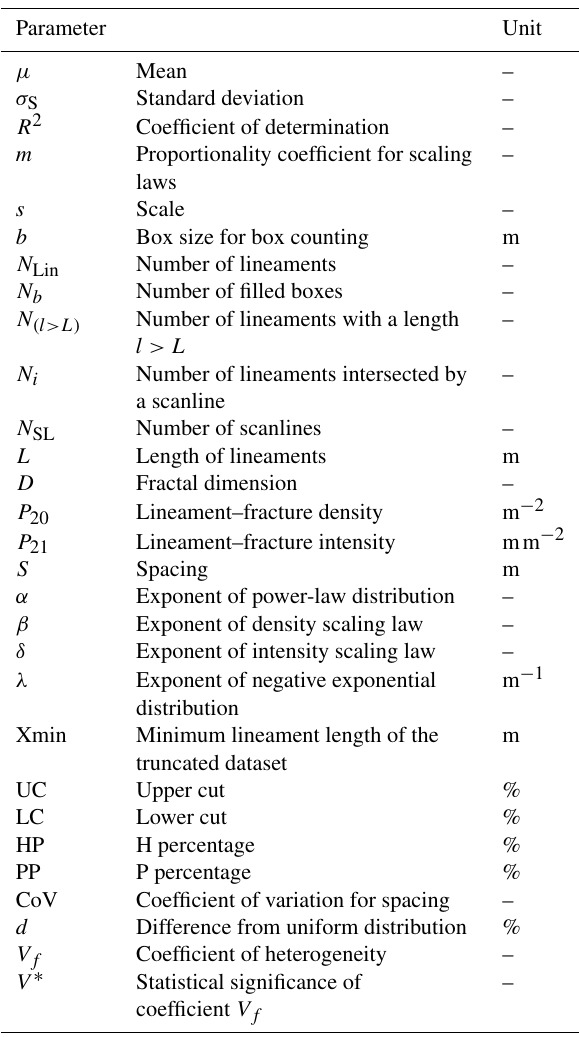
Table 1. Summary table of the parameters and related nomenclature adopted in this